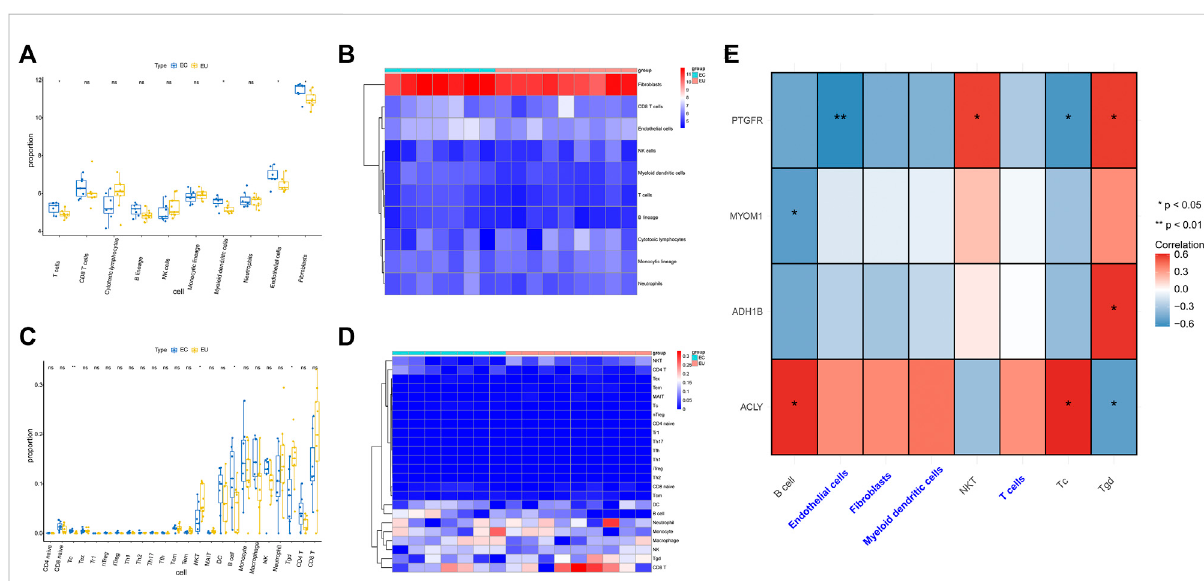
FIGURE 7 The characteristic genes and in fi ltrating immune cells. (A) The box plot of cell content was calculated by MCP-counter between different EU and EC groups. (B) The heat map of different cell contents was calculated by MCP-counter. (C) The box diagram of immune cell difference between EU group and EC group was calculated by ImmuneCellAI. (D) The heat map of different cell contents was calculated by ImmuneCellAI. (E) The heat map showed the correlations between immune cells and the characteristic gene. ceRNA regulatory network for characteristic